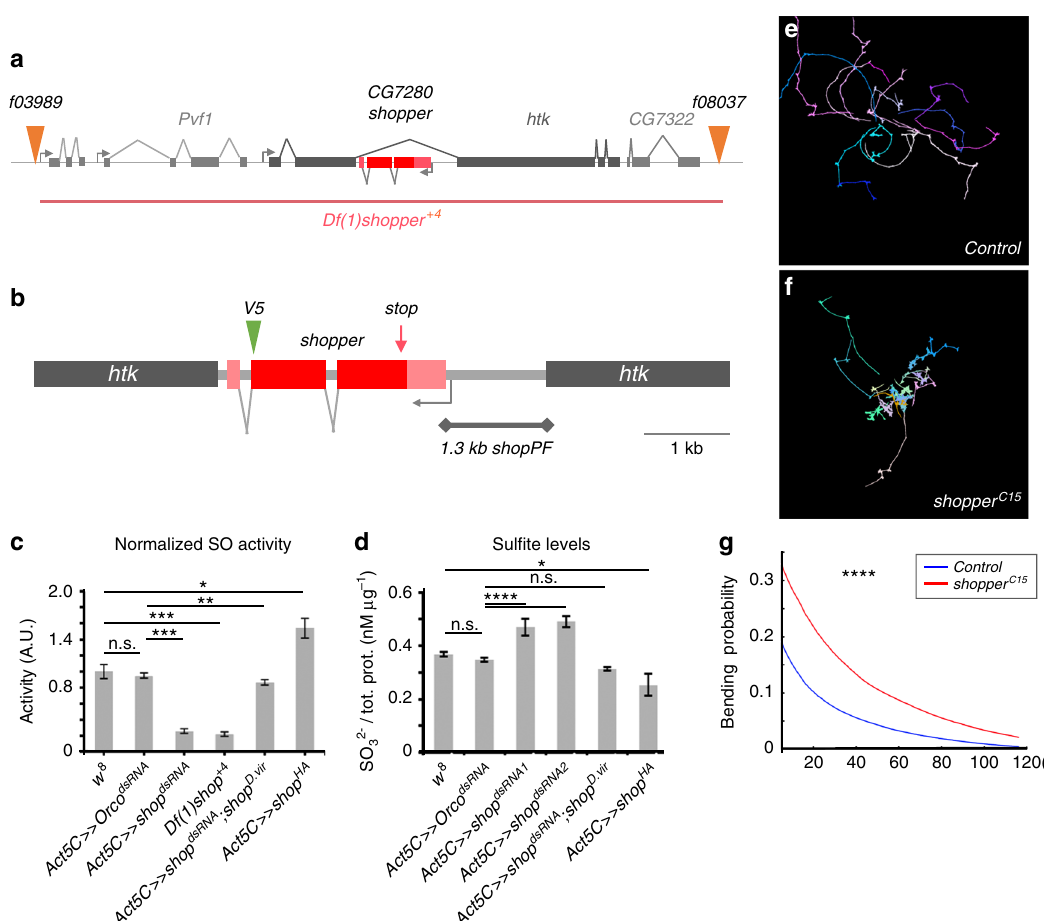
Fig. 4 Genetic and biochemical characterization of the sul fi te oxidase Shopper . a The shopper locus on the X chromosome. The shopper gene is depicted in red. It resides in an intron of the gene hat-trick ( htk ). Two FRT-elements carrying transposon insertions ( f03989 , f08037 ) used to generate the chromosomal de fi ciency Df(1)shopper + 4 are indicated. b The position of a V5 tag integrated in a CRISPR-based approach ( shop V5 ) and the position of a CRISPR-induced premature stop codon in an amorphic allele ( shop C15 ) are indicated. A 1.3 kb fragment of the presumed shopper promoter region was used to generate an expression construct ( shopPF ). c Measurement of sul fi te oxidase activity in different genotypes as indicated. The sul fi te oxidase activity is drastically reduced upon lack of shopper either by ubiquitous suppression ( Act5C-Gal4 ) or in shopper-de fi cient animals ( Df(1)shopper + 4 ) compared to controls. Ubiquitous co-expression of a shop dsRNA and a D. virilis interspecies rescue construct restores sul fi te oxidase activity. Overexpression of shopper increases the activity compared to controls. d Determination of whole lysate sul fi te levels in different genotypes as indicated. shopper dsRNA1 corresponds to 7280 R-1 , and shopper dsRNA2 corresponds to the KK105942 line. e Locomotion trajectories of third-instar larvae from a CRISPR control strain show the wild- type pattern. f Locomotion trajectories of shopper C15 mutant third-instar larvae show an increased head bending frequency. g The head bending probability is strongly increased in mutants ( n = 184 trajectories) compared to controls ( n = 162 trajectories). Bar graphs represent the mean normalized enzyme activity or compound levels, as well as the standard deviation of three technical replicates. Three independent experiments were conducted. >600 Frames of ~120 larvae, * p < 0.05, ** p < 0.01, *** p < 0.005, **** p < 0.001, n.s.: not signi fi cant, t -test ( c , d ), Wilcoxon rank-sum test ( g